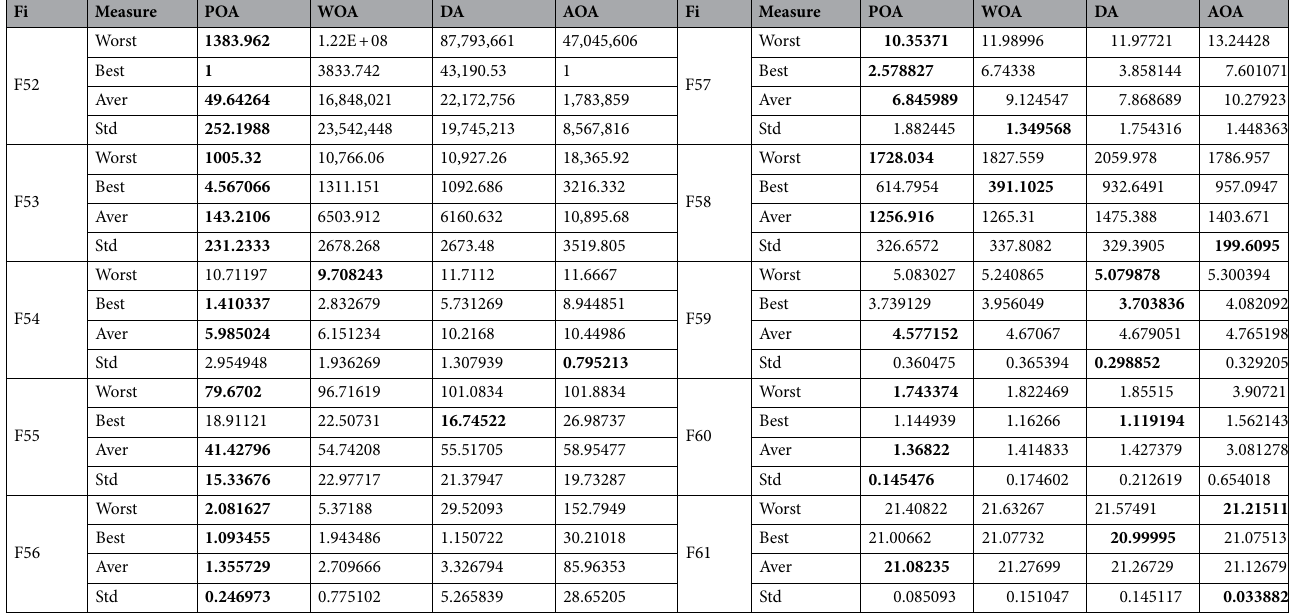
Table 11. Results of CEC 2019 problems. Significant values are in bold.